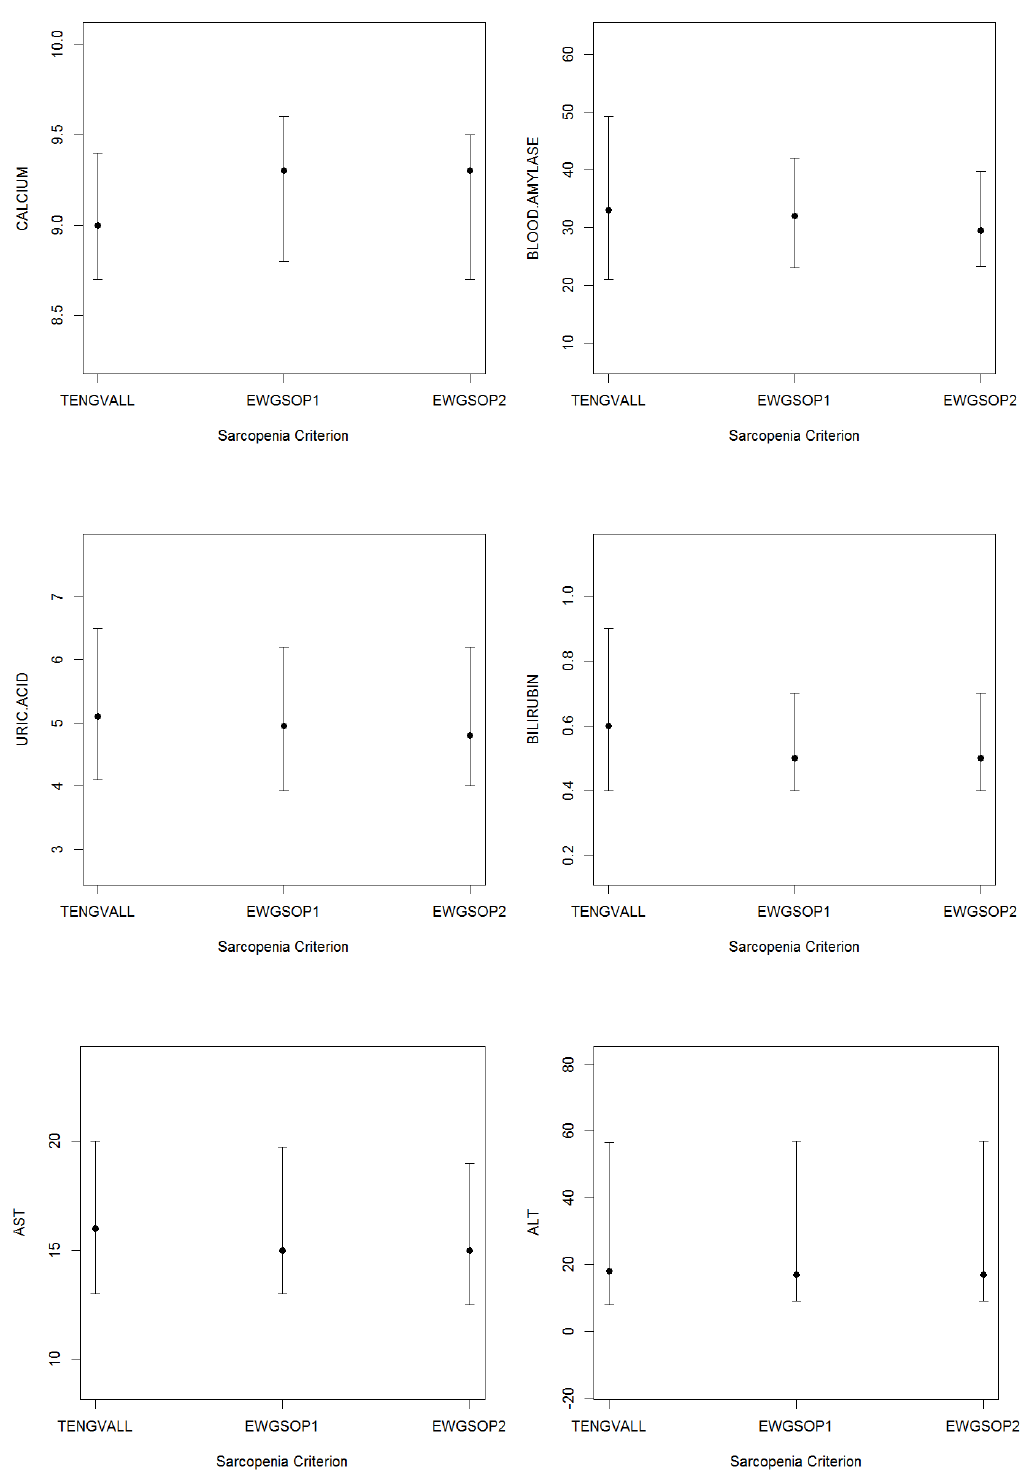
Figure A5. Summary for patients with low ASMI characteristics under each diagnostic criterion. The points represent medians, while lower and upper quartiles are represented by the vertical bars.